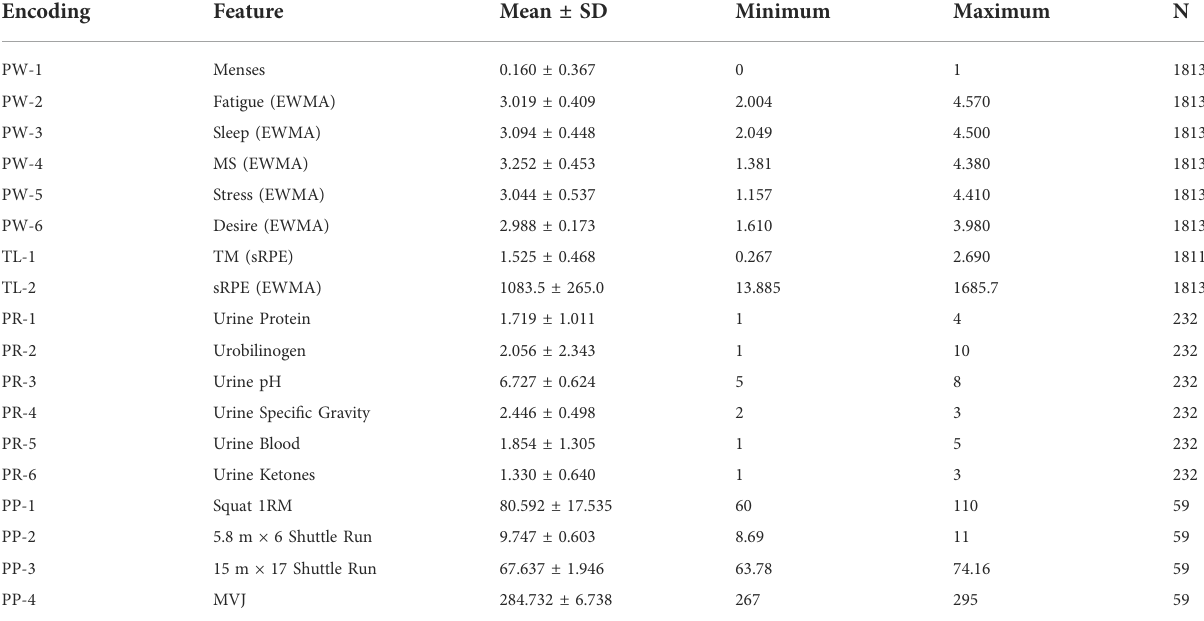
TABLE 3 Distribution of each variable in the primary dataset.